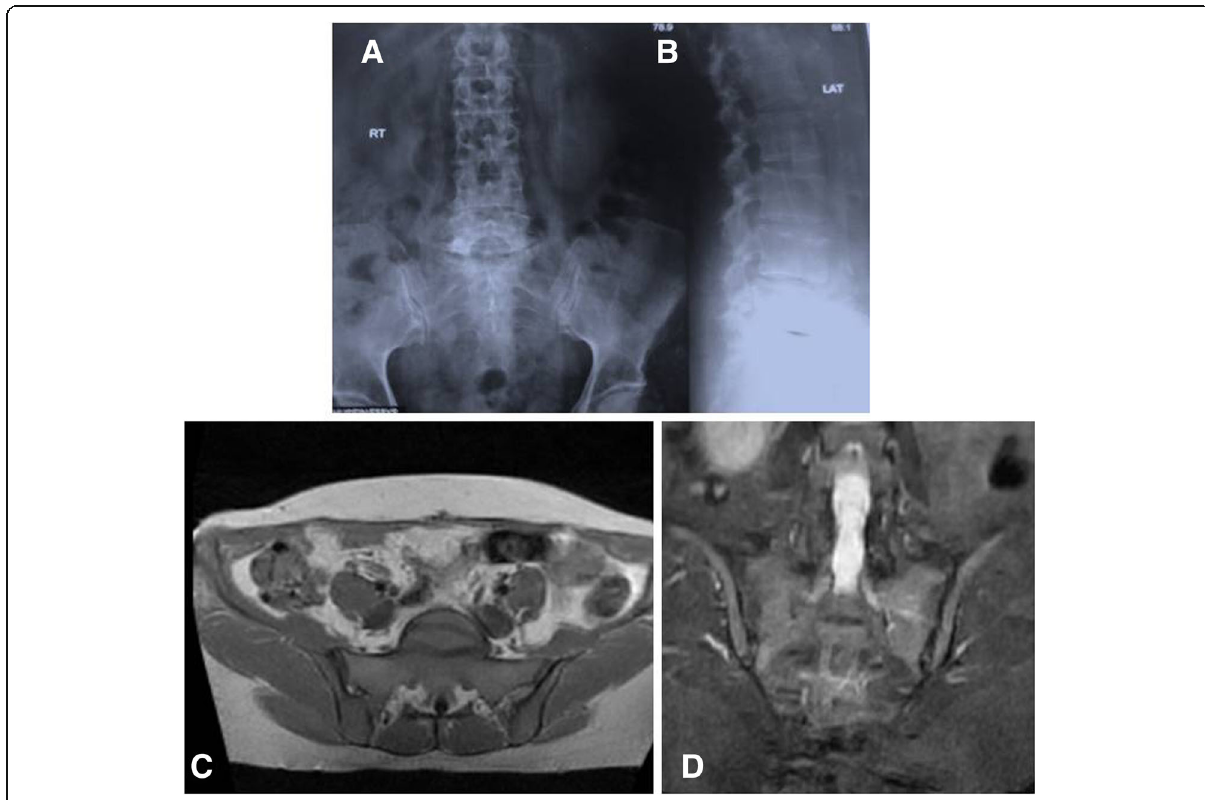
Fig. 1 Female patient 44 years with rheumatoid arthritis. a Plain X-ray lumbar sacral spine AP and lateral views showed lumbar spine syndesomophtes of the facet joints with degenerative disc changes and narrowed sclerotic sacroiliac joints. c Axial MRI T1WI and d coronal T2WI of the sacroiliac joints showed early peri-articular edema